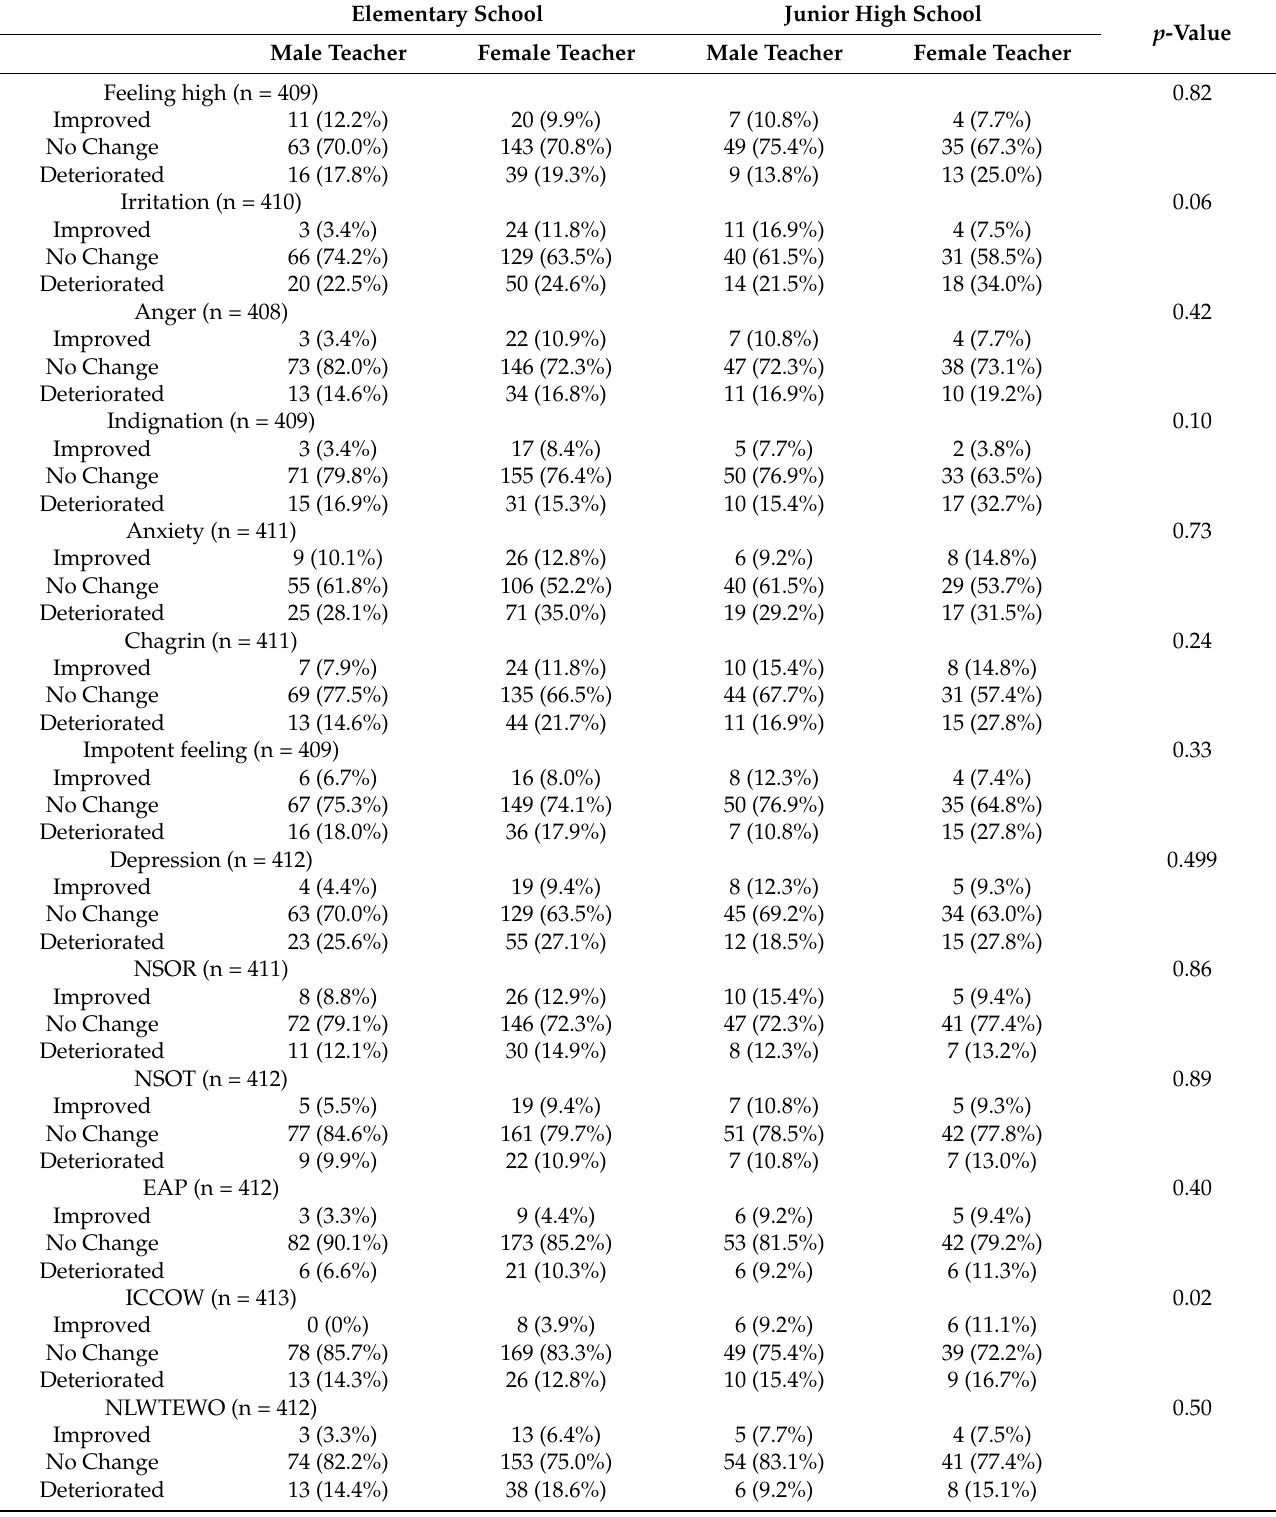
Table 2. Changes in psychological conditions before and after school closures due to